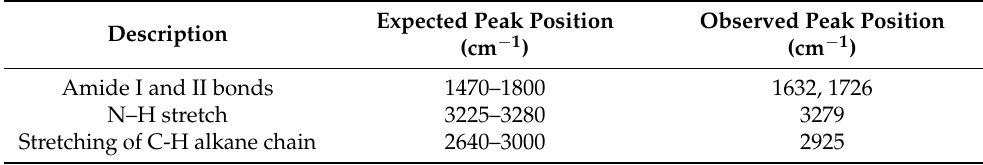
Table 1. FTIR peaks confirming SAM formation